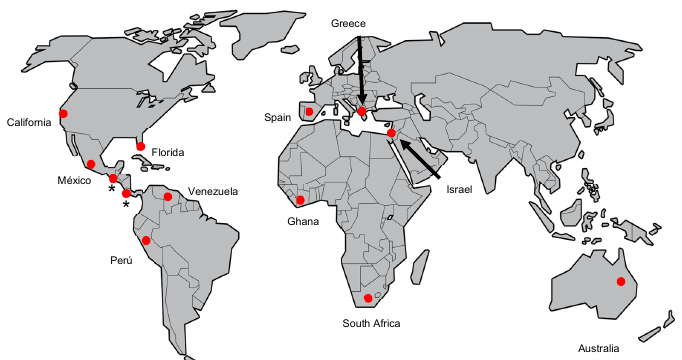
Figure 4. Geographical distribution of ASBVd in the five continents: America (USA, Venezuela, Perú, México), Europe (Spain, Greece), Asia (Israel), Africa (Ghana, South Africa), and Australia. 1.